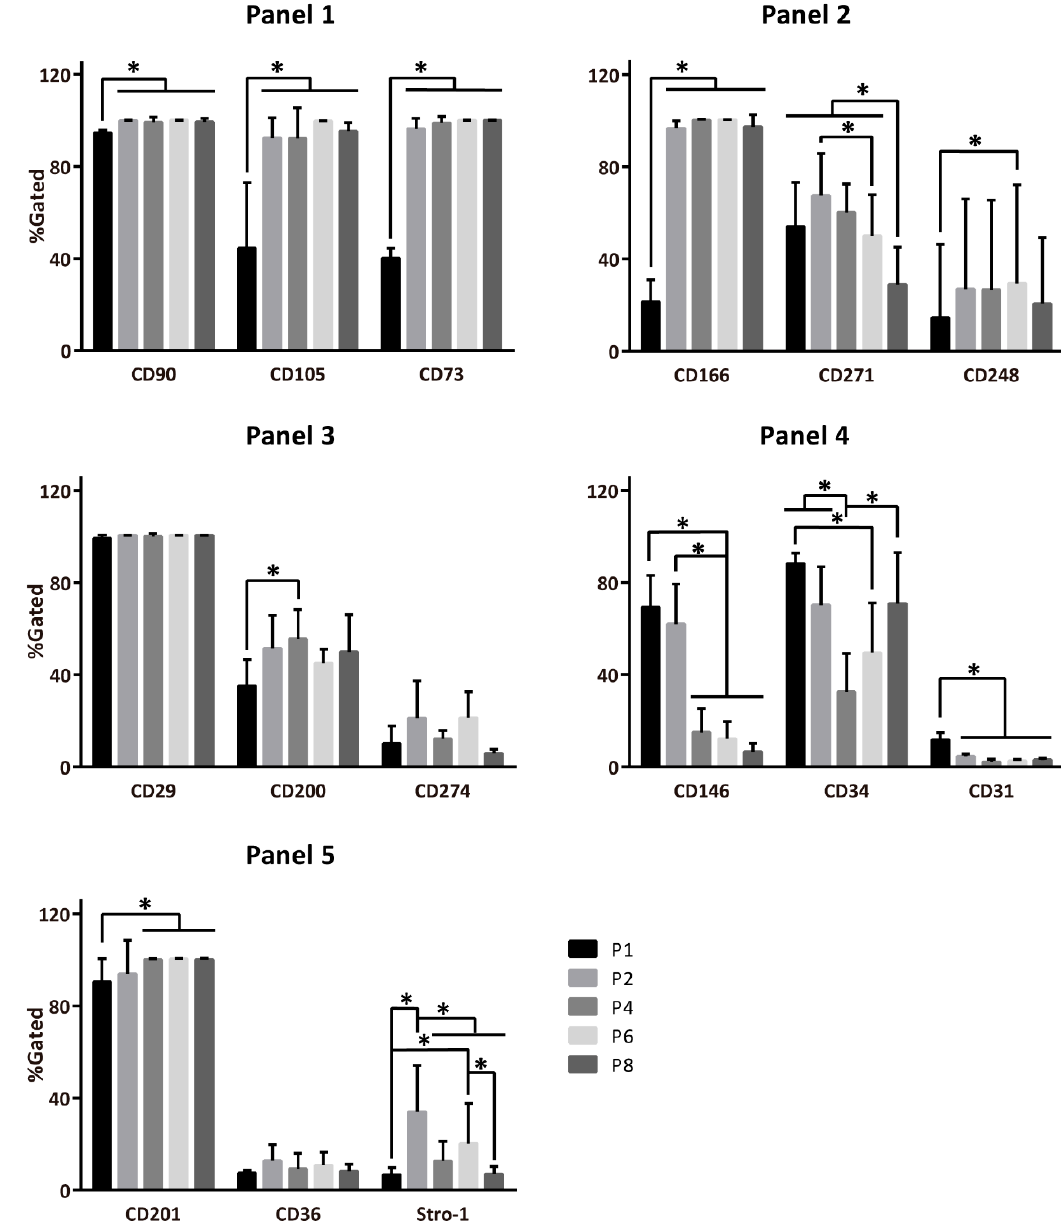
Figure 2. Development of single-marker expression across population expansion. Panels: 1, MSC markers; 2, wound healing markers; 3, immune regulation markers; 4, ASC markers, 5, differentiation capacity markers. ASC; adipose-derived stromal/stem cells, CD; cluster of differentiation, Passage 1–8 (P1–8). The data are presented as means + standard deviation, n = 7–8, * indicates a statistically significant change p < 0.05.